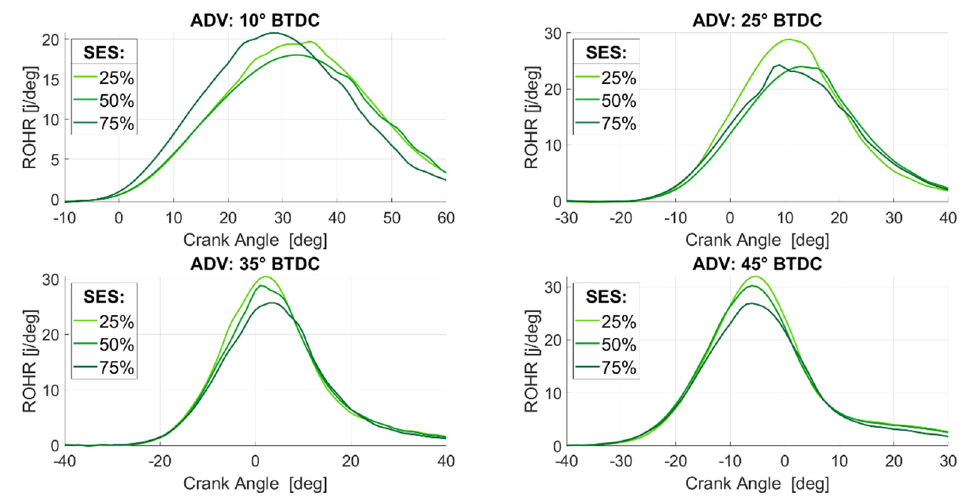
Figure 4. ROHR developments for each of the three gas mixtures (SES 25%, 50%, and 75%) at different spark advances (10°, 25°, 35°, and 45° BTDC).